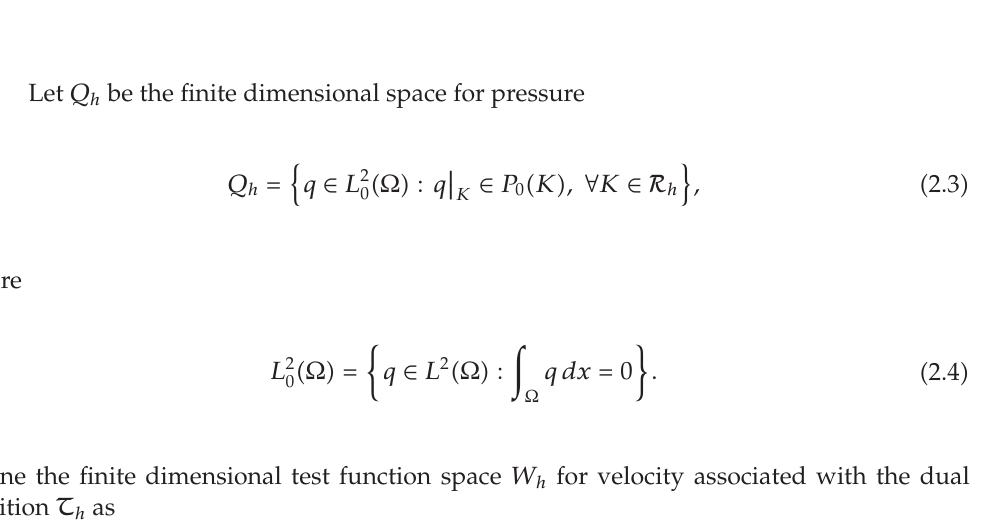
Figure 2: Element T ∈ T h for rectangular